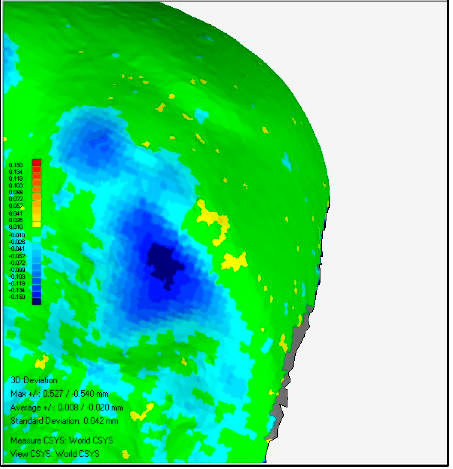
Figure 6. Example of a signal gradient image with clearly defined level lines. Sensitivity, specificity, and positive and negative predictive values were assessed to evaluate the efficacy of the scanner. The data collected at each moment of the measurement were used to calculate the sensitivity and specificity. For their preparation, the Smith and Knight visual test was used as a reference for patients and non-diseased patients (considering those classified in stages 1–4 as diseased), and as a diagnostic test was used to validate the 3M ® True Definition intraoral scanner (healthy or negative result: 0, and diseased or positive result: